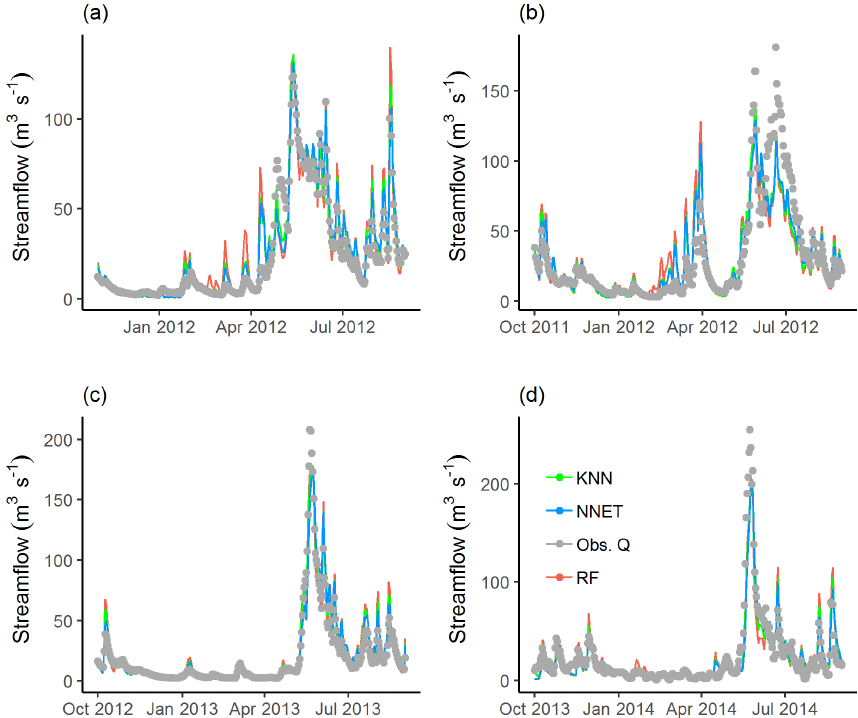
Figure 4. Simulated and observed streamflow values for the calibration period, i.e. year 2011 (a) , and validation periods, i.e. years 2012 (b) , 2013 (c) , and 2014 (d) . The behavioural models are identified using the coupled MLMs (RF, KNN, and NNET) and GLUE pLoA.